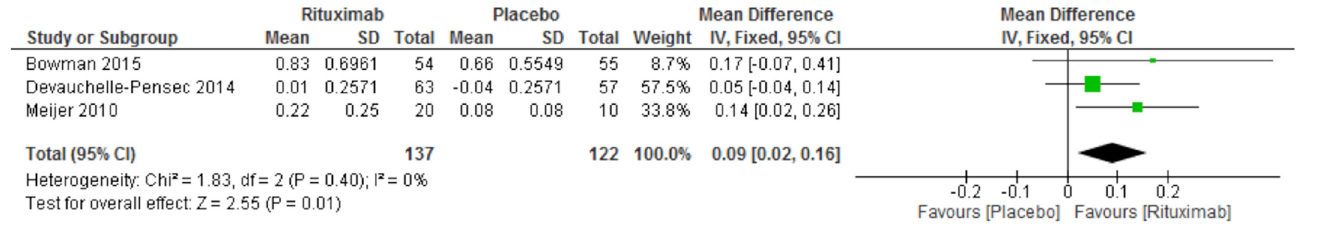
Fig 4. Rituximab X Placebo. Meta-analysis of the outcome salivary flow rate at week 24.